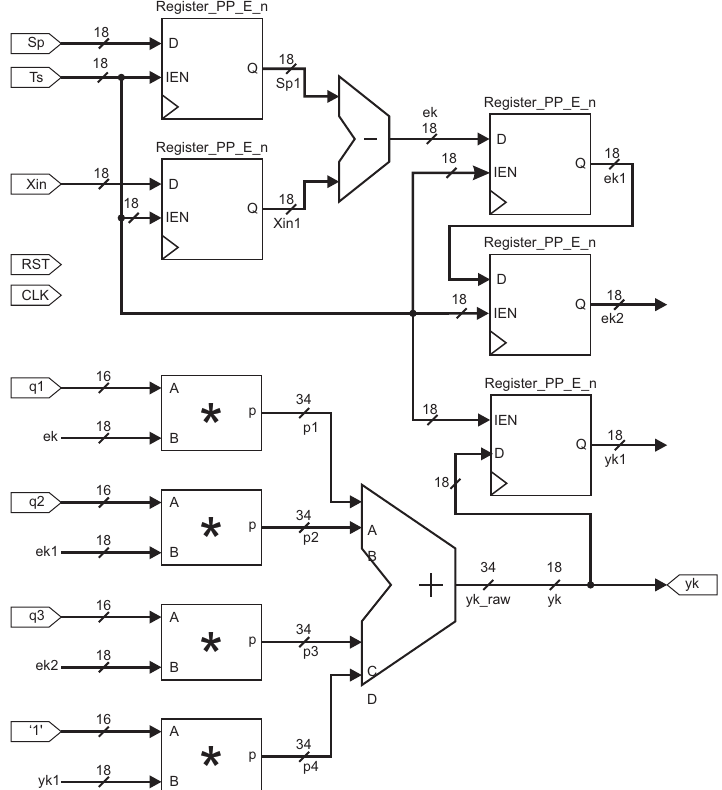
Figure 8. VHDL diagram block for PID controller. The symbol * in this figure represents a multi- plier